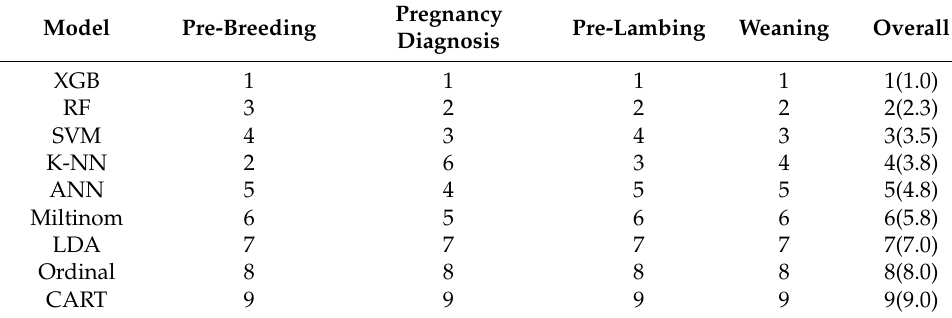
Table 5. Model ranking by stage of annual cycle and